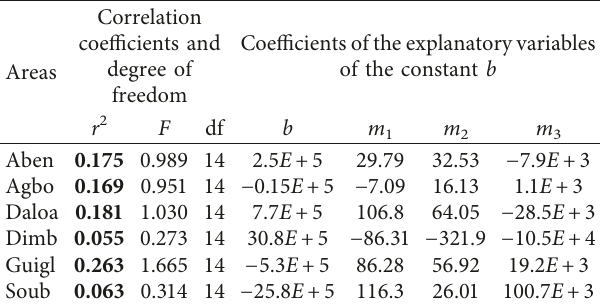
Table 1: Multiple regression coefficients applied to the explanatory variables (i.e., precipitation and temperature) and the explained variable (i.e., cocoa production) for each studied department over the 1989–2006 period.